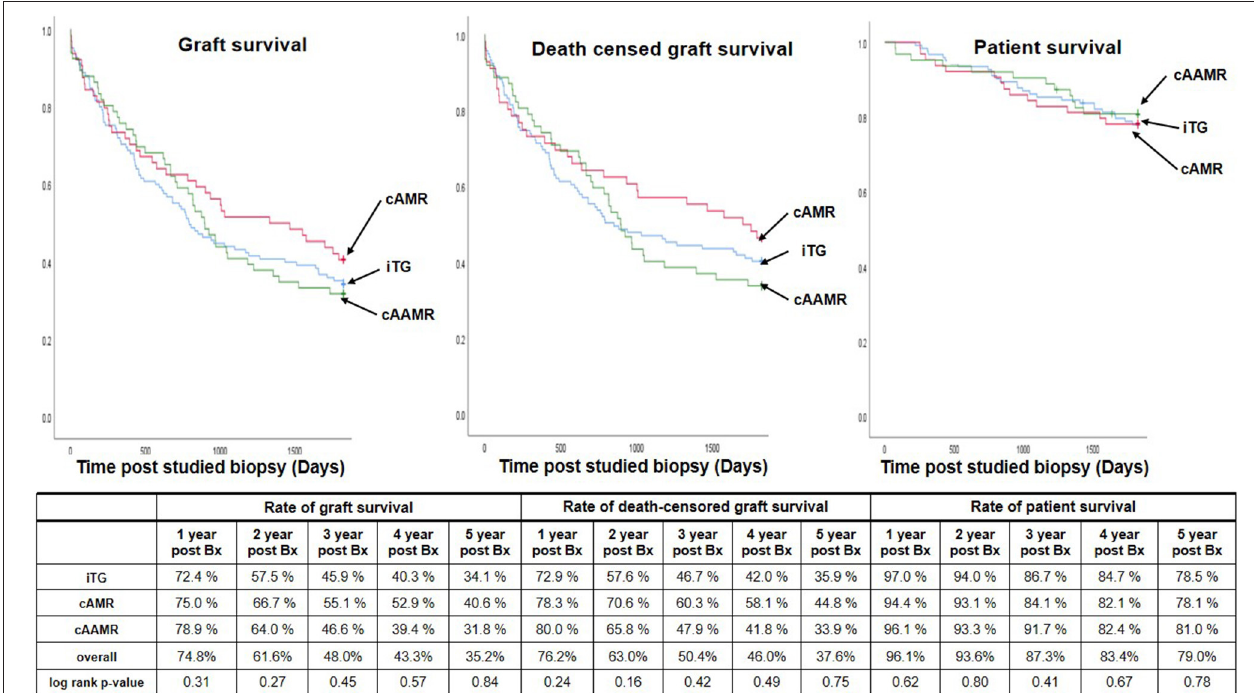
TABLE 4 | Binary logistic-regression analysis of clinical and histologicl factors associated with 5-year outcome after diagnosis of transplant glomerulopathy. Graft loss Patient death Death-censored graft loss OR 95% CI p -value OR 95% CI p -value OR 95% CI p -value